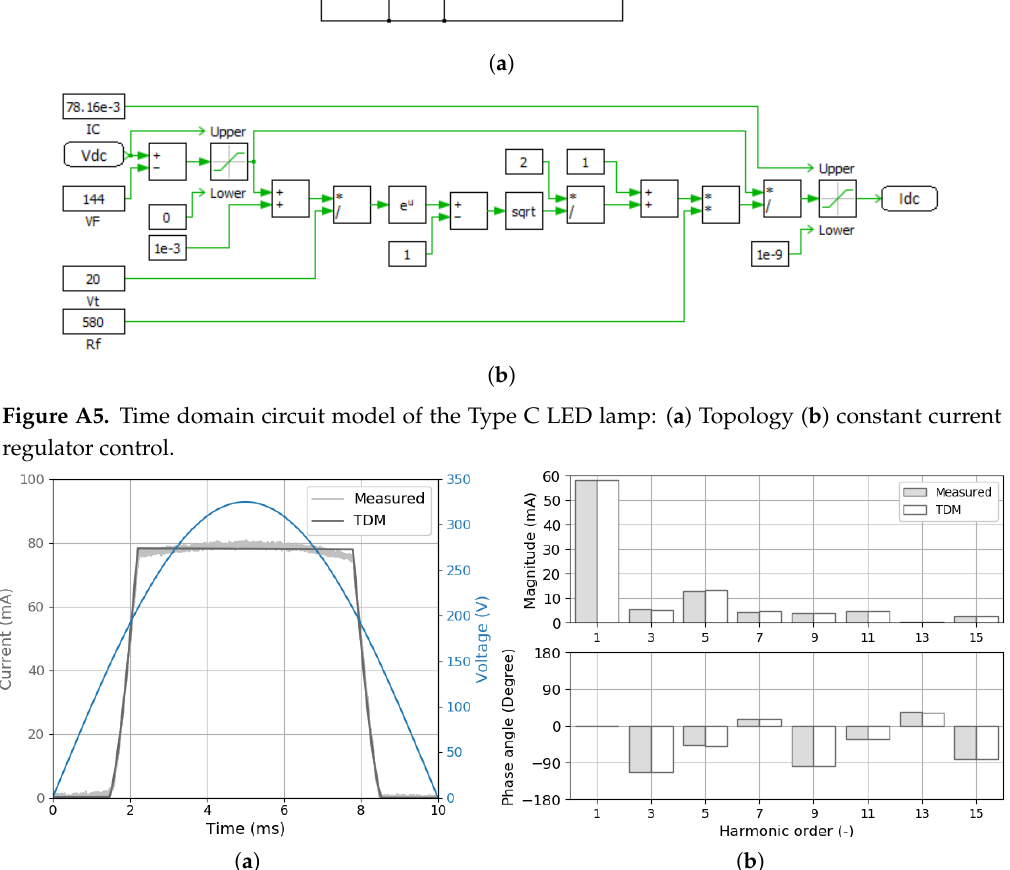
Figure A6. Comparison of measured data and the Type C LED lamp time-domain model (TDM) output at rated ideal sinusoidal condition: ( a ) Time domain. ( b ) Spectral